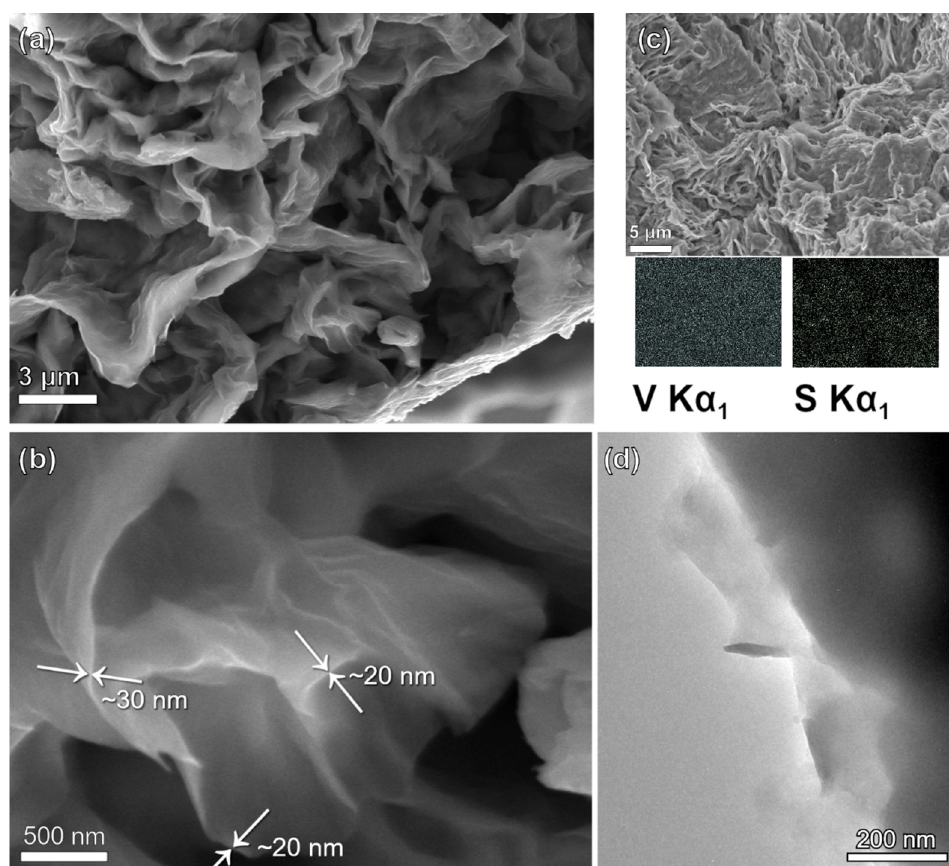
Figure 2. ( a , b ) SEM images of VO@PEDOT; ( c ) SEM image with the corresponding EDX mapping of V and S elements; ( d ) TEM image of VO@PEDOT.